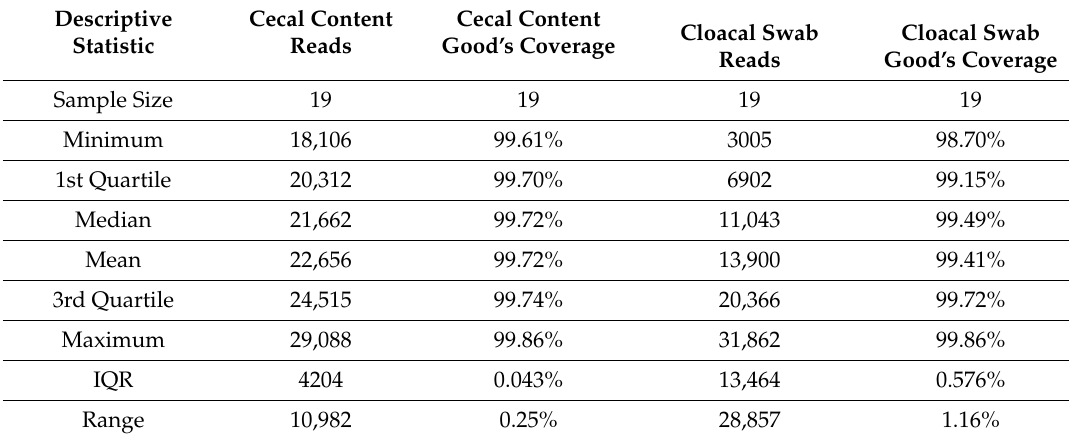
Table 1. Descriptive statistics of the sequencing data for the nineteen cecal content and nineteen cloacal